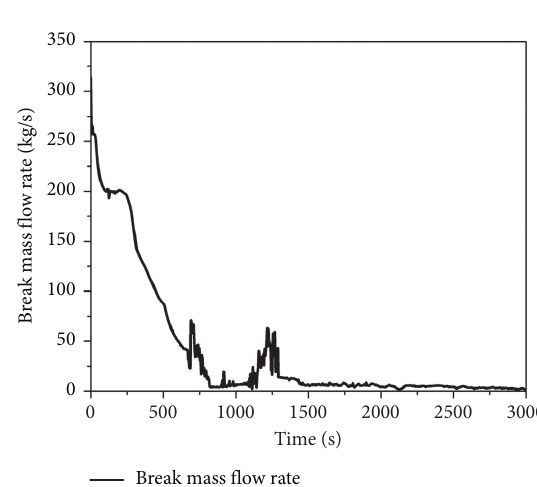
Figure 20: DEDVI break mass flow